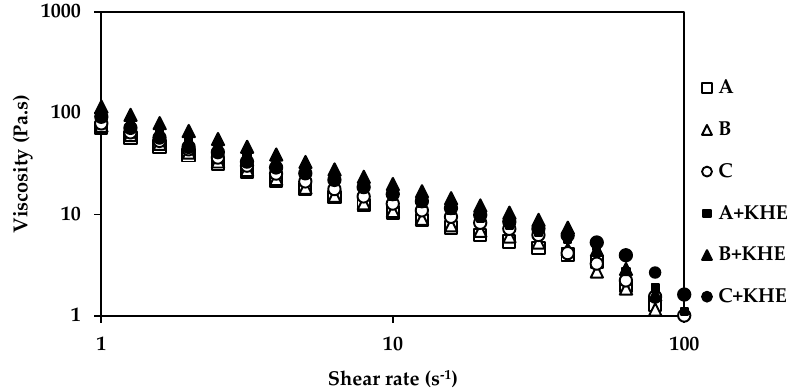
Figure 1. E ff ect of shear rate on apparent viscosity gel-in-oil emulsions A, B and C with khellin (KHE), and a comparison with the respective vehicles.